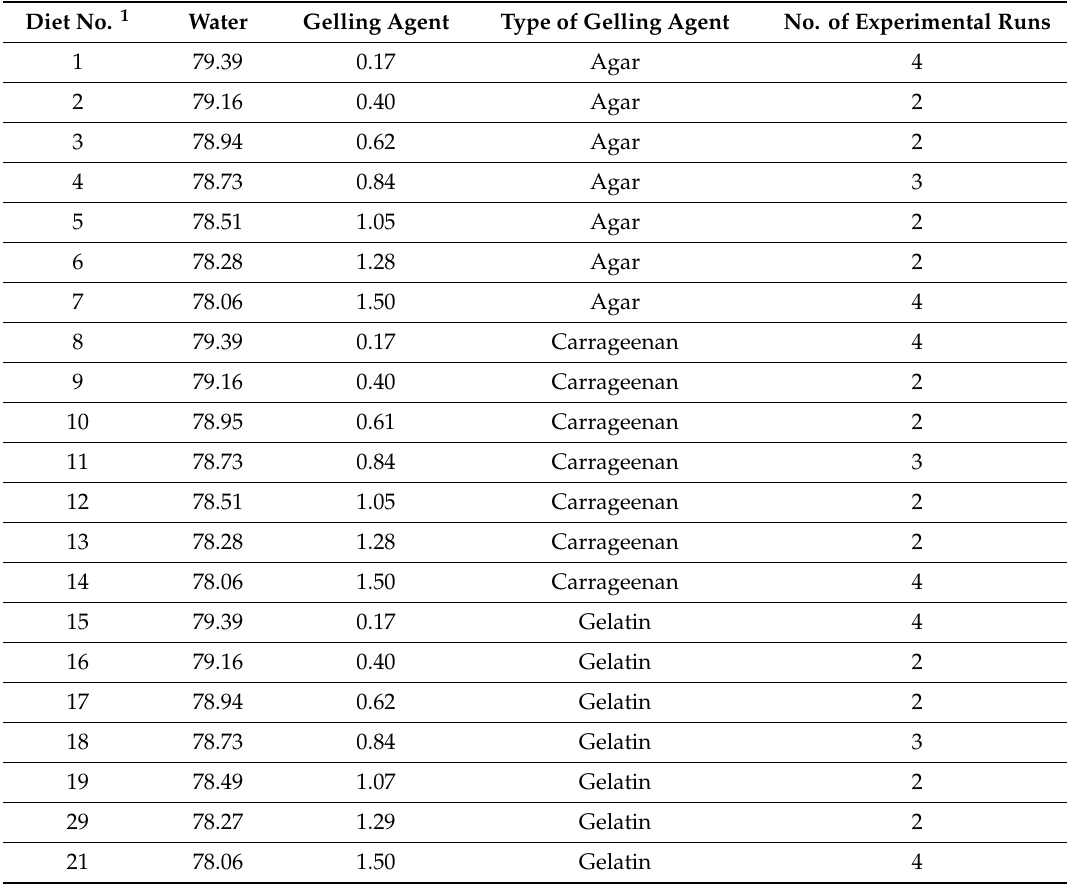
Table A2. Gel diet formulations tested in Experiment 2. The values of diet ingredients are given as percentages ( w / w ).